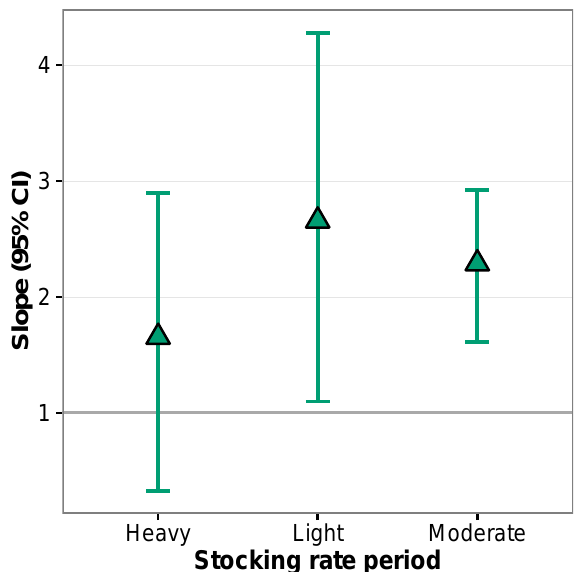
Figure 2. Slope coefficients and 95% confidence intervals for linear regression models fitting the logarithm of standing crop variance against the logarithm of mean standing crop for each grazer density. Data support the portfolio effect when the slope of the regression equation for log (variance) vs. log (mean) > 1.0 and 95% confidence intervals do not overlap 1.0. The portfolio effect mirrors temporal stability in standing crop as underpinned by functional group